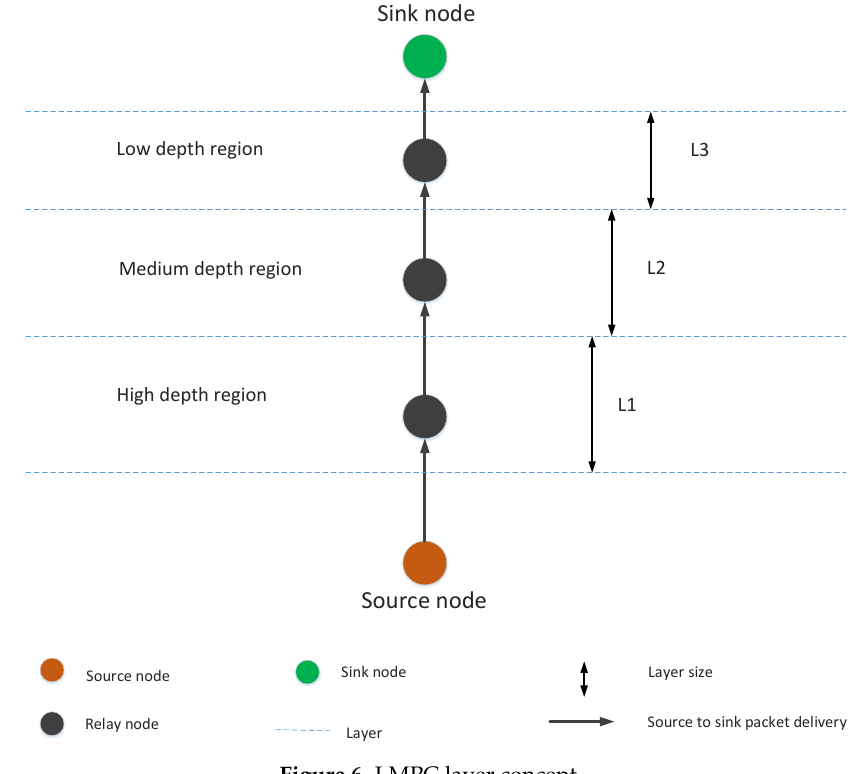
Figure 6. LMPC layer